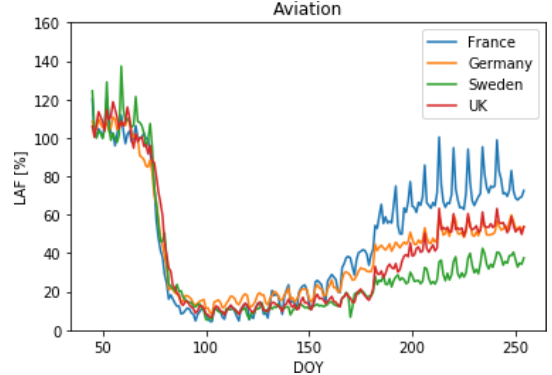
Figure A1. Daily values for lockdown adjustment factors (in %) for the sector F_RoadTransport based on transit data from the Google mobility reports.